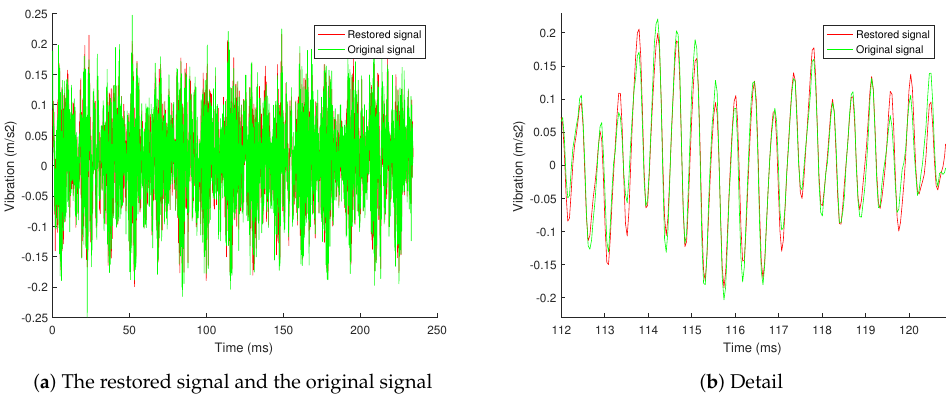
Figure 7. The comparison between the signal restored by the 4 sub-signals and the original signal.